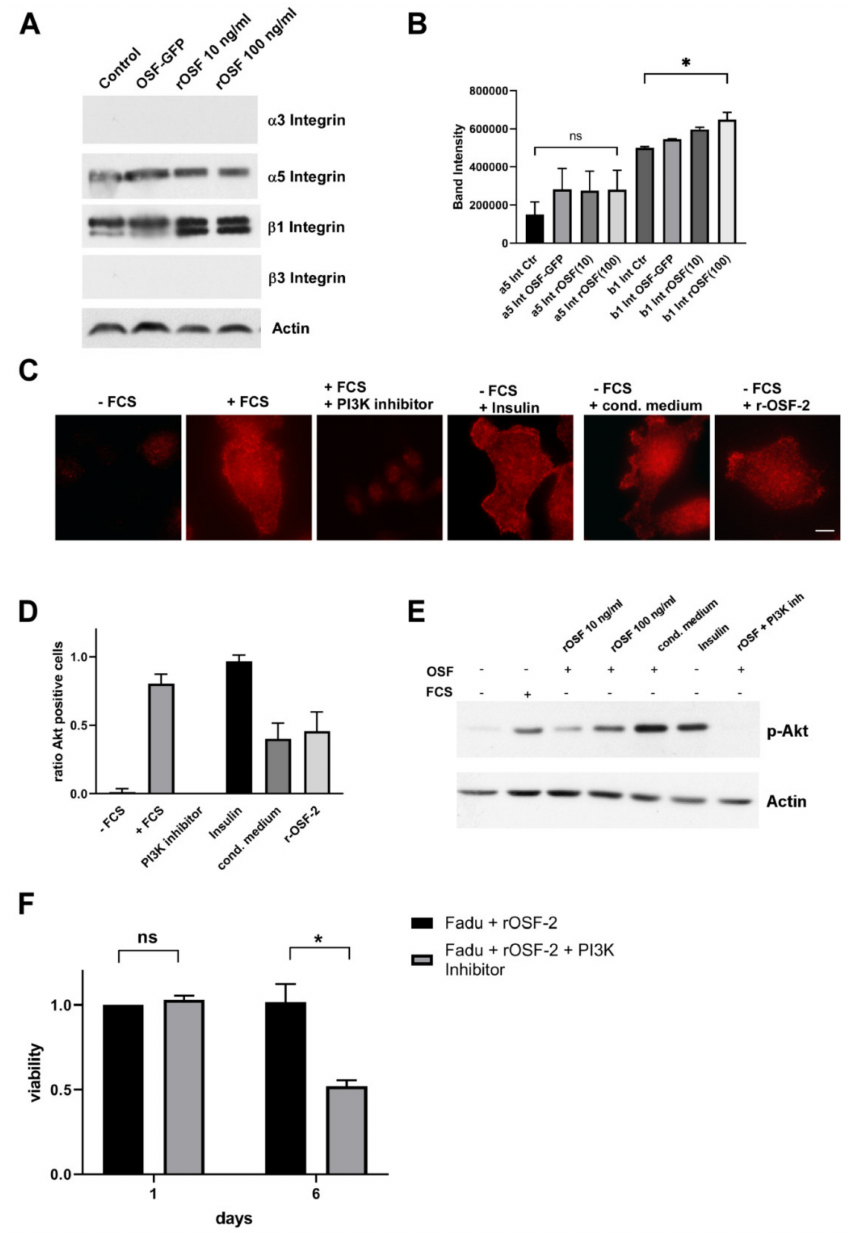
Figure 8. OSF-2 stimulates the Akt/PKB pathway via integrin-dependent PI3-Kinase activation. ( A , B ) β 1-integrin, but not α 5 integrin is induced by the addition of rOSF-2 (10, 100 ng/mL). Integrin receptor expression was analyzed by Western blot in HNSCCUM-02T cells. Actin served as the loading control. Representative results ( n = 2) are shown. Densitometric analysis of detected bands